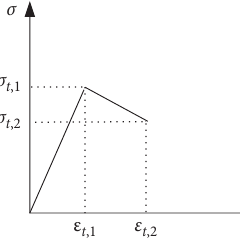
Figure 5: Schematic diagram of the mechanical properties of reinforced concrete materials under axial